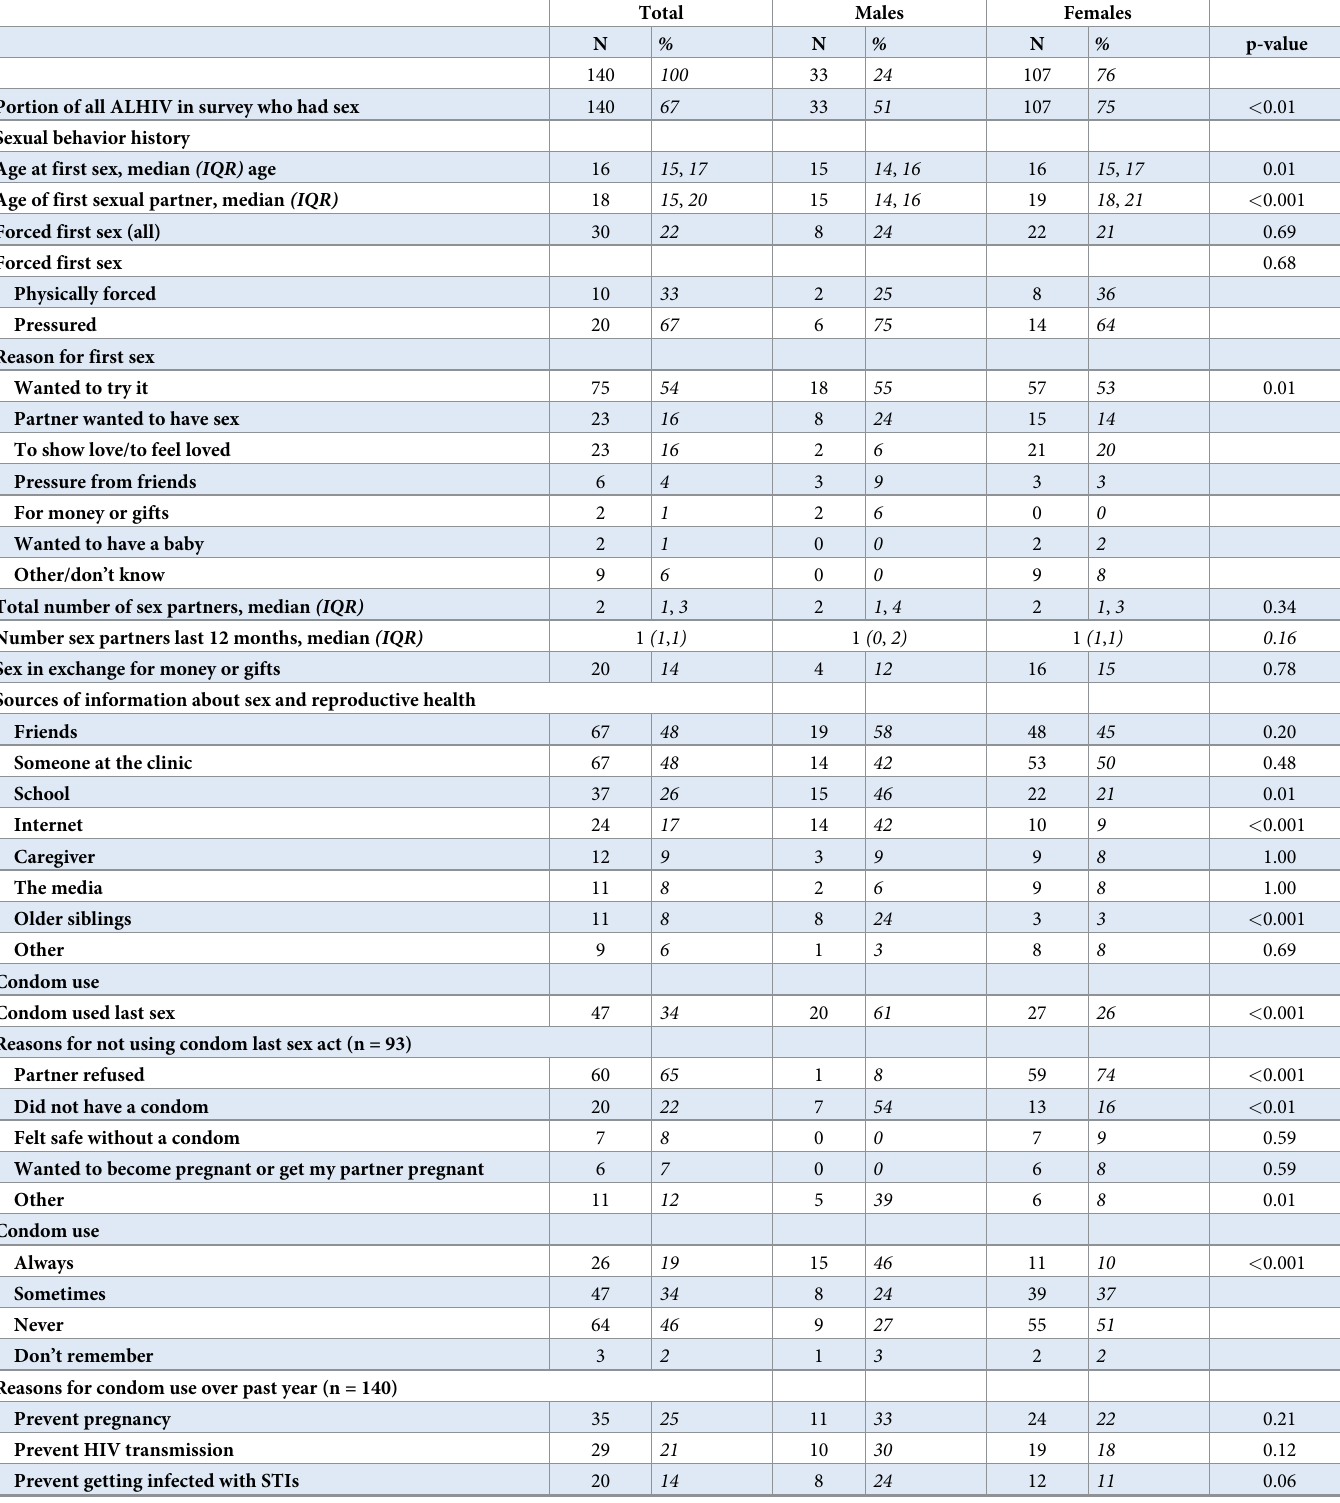
Table 4. Sexual behaviors and condom use among ALHIV 15–19 years of age who have had vaginal intercourse in Nampula, Mozambique, 2019 (N = 140). Total